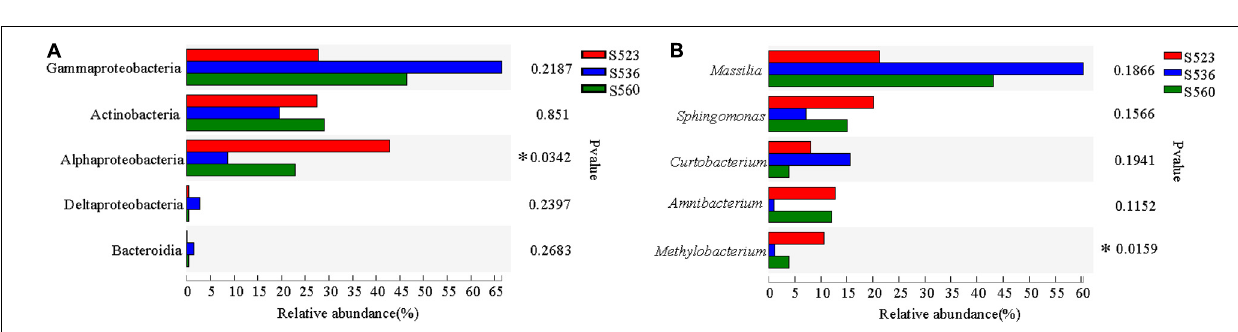
FIGURE 1 | The relative abundance of the litter bacterial community at the class (A) and genus (B) level over different phytoremediation years.